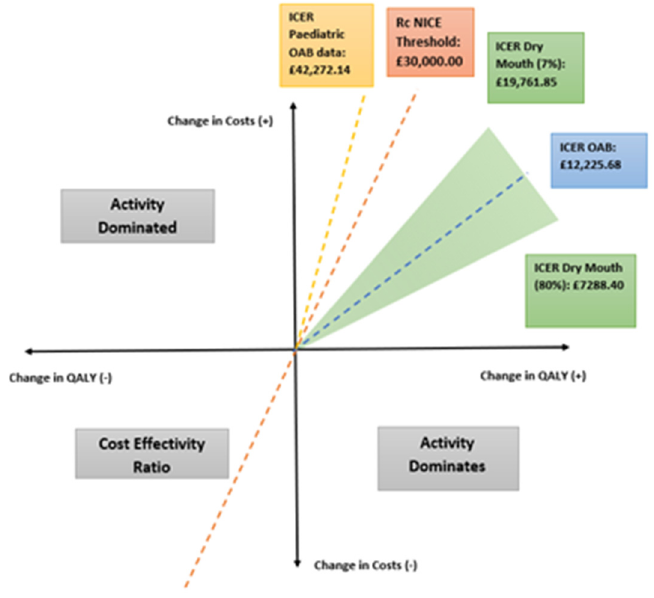
Figure 3. Cost-effectiveness. Figure 3.